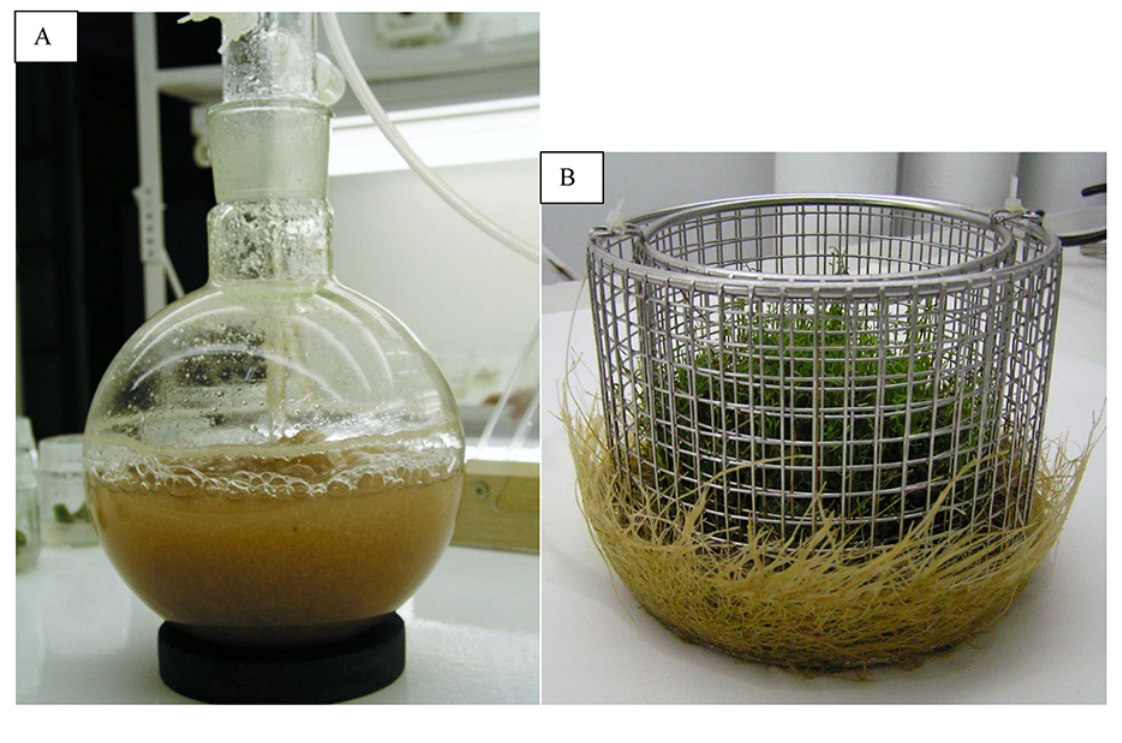
Figure 14 Genista tinctoria ( A ) suspension and ( B ) shoot/hairy root